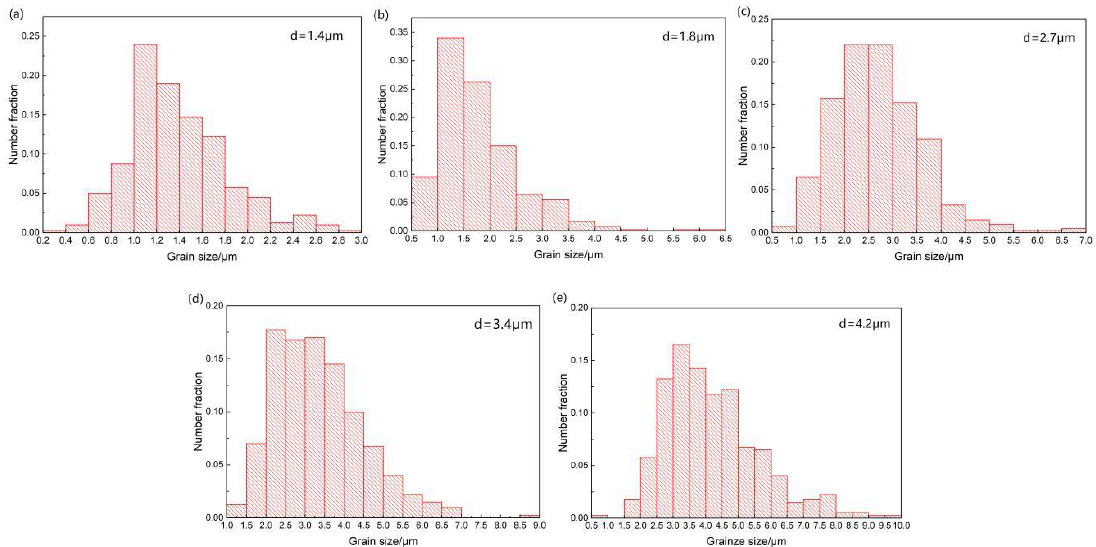
Figure 4. Grain size distribution of rolled ZK60 magnesium sheet under di ff erent strain rates. ( a ) 5 s − 1 ( b ) 10 s − 1 ( c ) 15 s − 1 ( d ) 20 s − 1 ( e ) 25 s − 1 .